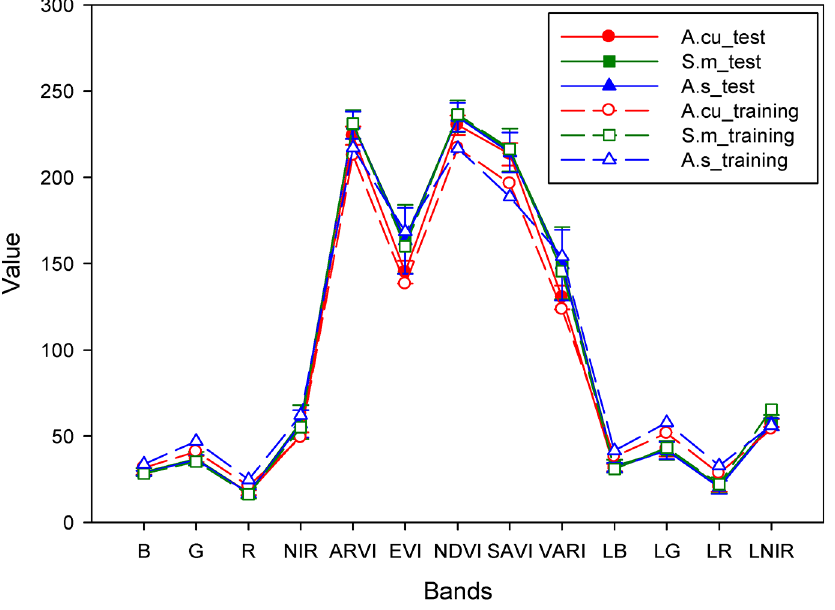
Fig 5. An example of the species classification uncertainty caused by spectral signatures